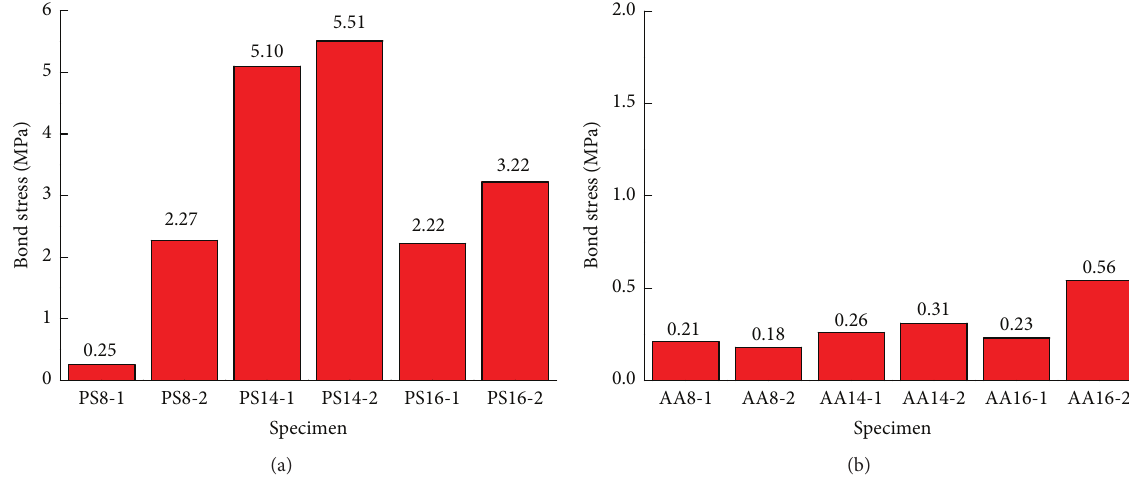
Figure 7: Effect of embedment length on bond strength of plain bars: (a) plain bar and (b) plain